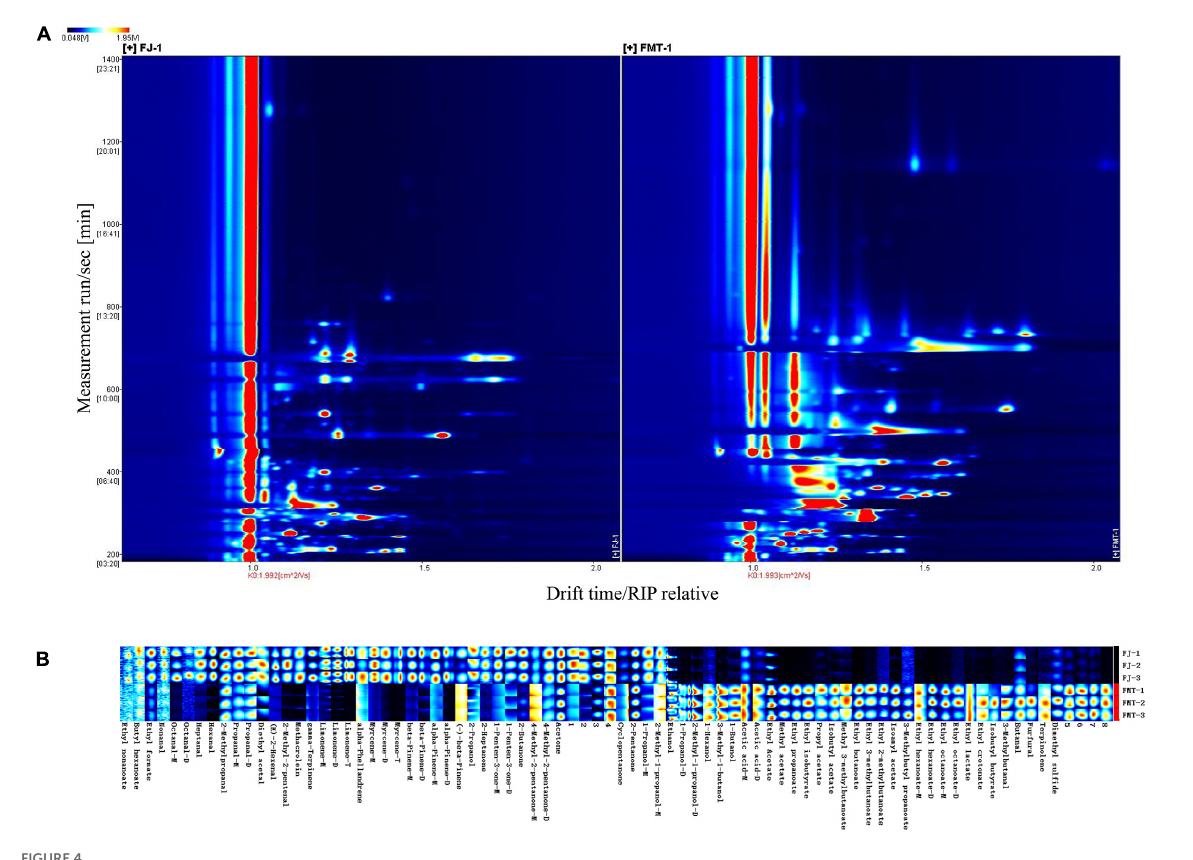
FIGURE4 Gas chromatography-mass spectrometry spectrum of the FJ and FMT samples ( A , a top view) and Gallery plot fingerprint of volatile substances (B)